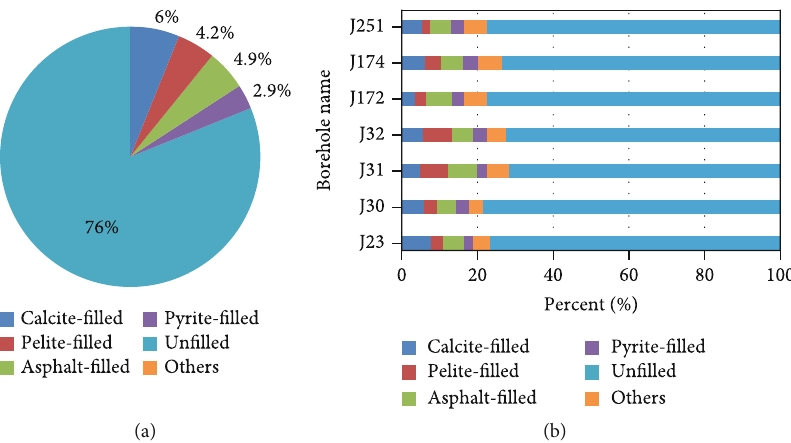
Figure 9: (a) Fan chart of bedding fracture fi lling of Lucaogou formation in Jimsar sag. (b) Stacked bar graph of bedding fracture fi lling condition in each borehole in Lucaogou formation in Jimsar